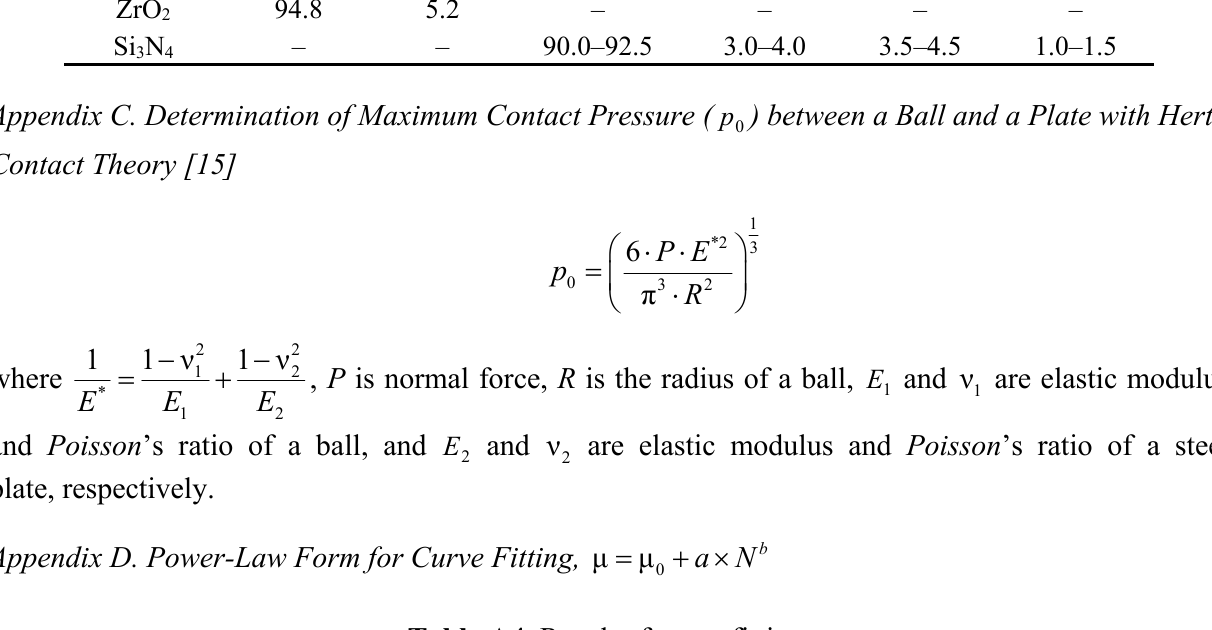
Table A4. Result of curve